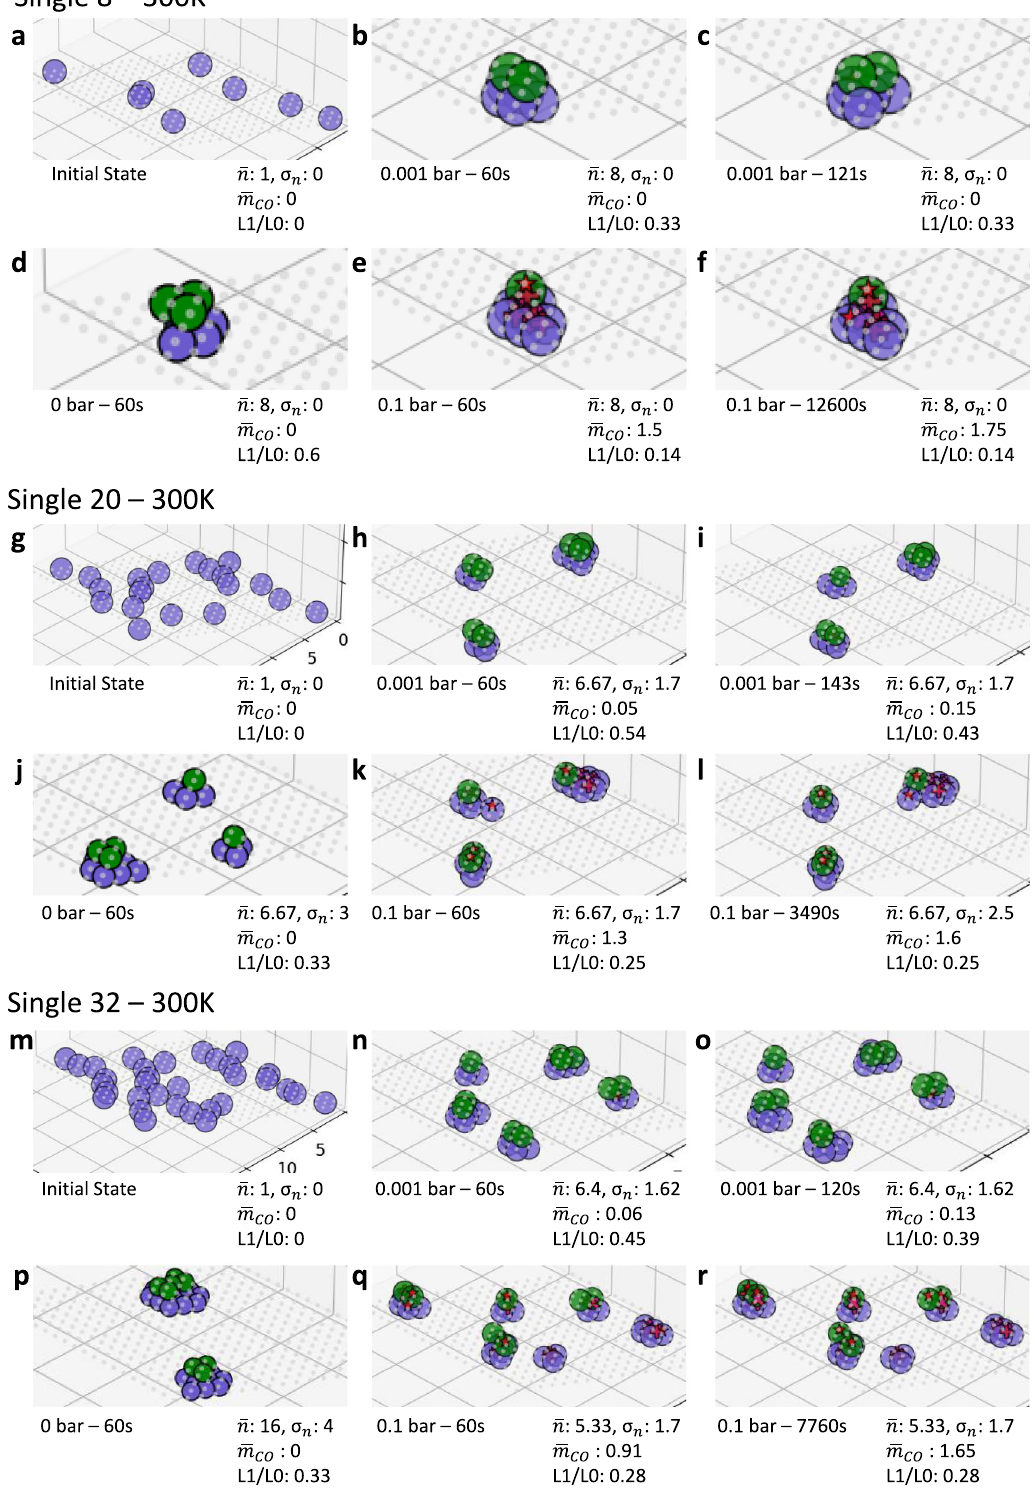
Fig. 4 Effect of loading and CO partial pressure on catalyst dynamics at 300 K. An initial state of ( a – f ) 8, ( g – l ) 20, ( m – r ) 32 single atoms (coverages of 0.02, 0.05, and 0.08 or 0.23, 0.57, and 0.92 wt%). For each loading/panel, the initial random con fi guration is at the top left of each panel with the bare cluster structure underneath. The second column shows snapshots at 60 s and the third for the longest time simulated in the presence of CO, and the top (bottom) row is for low (high) P CO . Color code: gray, empty lattice sites; red, CO; purple, Pd in the base plane L0, green: Pd in the second layer L1. Notation: (cid:1) n -average cluster size, σ — standard deviation of cluster size, (cid:1) m — the CO loading, L1/L0 ratio — the ratio of the number of Pd atoms in second and base n CO